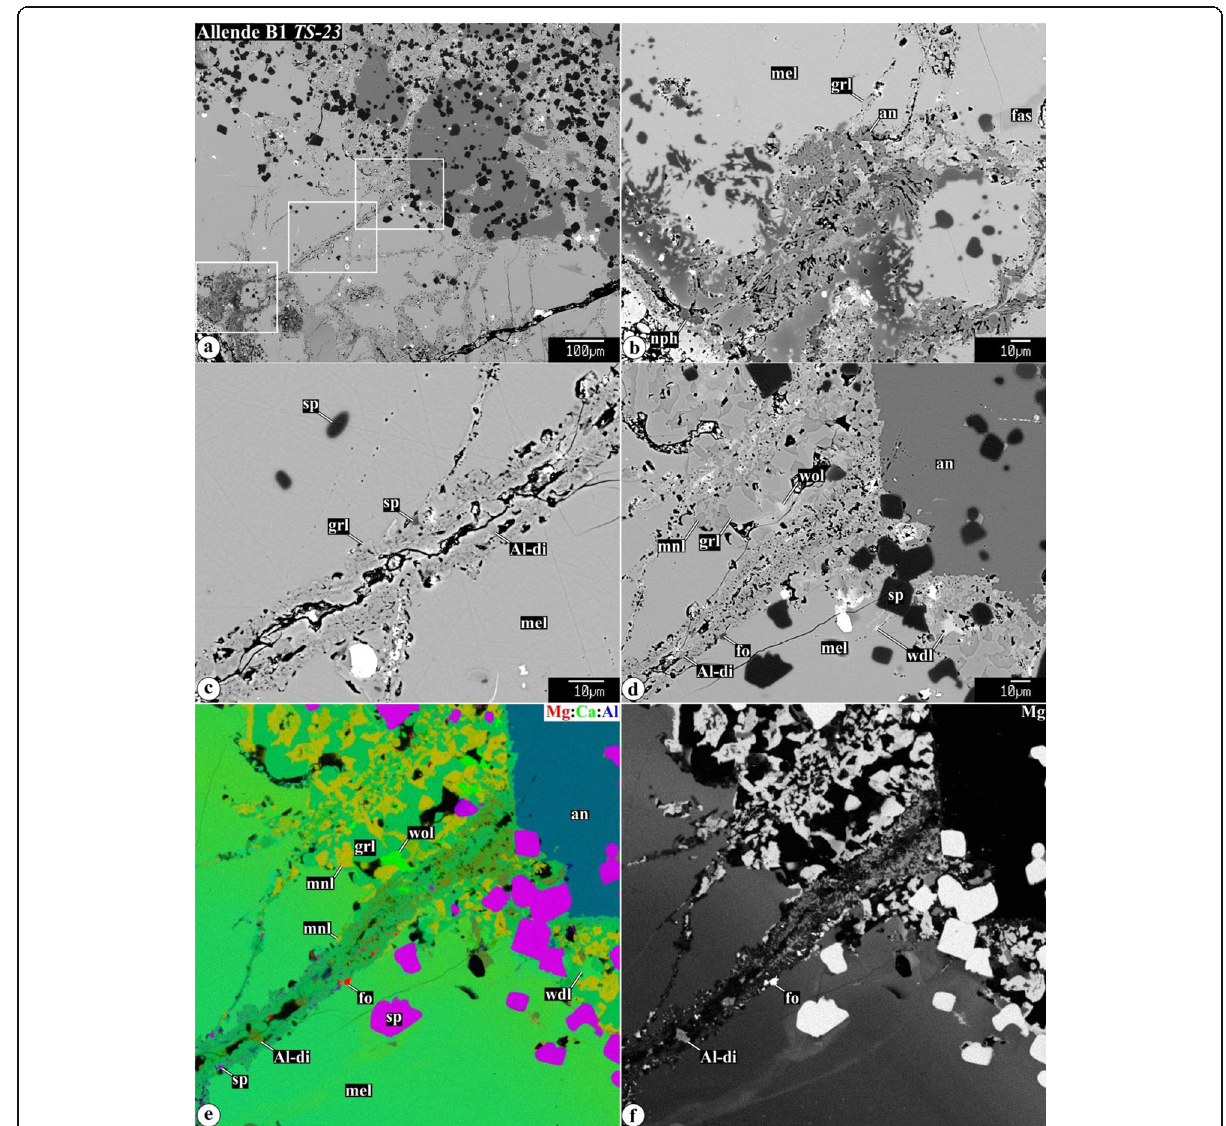
Fig. 5 a − d Backscattered electron images, e combined x-ray elemental map in Mg (red), Ca (green), and Al (blue), and f elemental map in Mg of a vein crosscutting gehlenitic melilite mantle around Type B1 CAI TS-23 . Regions outlined in a are shown in detail in b , c , and d − f , respectively. Towards the CAI interior, the melilite becomes more åkermanitic. The mineralogy of the vein changes towards the CAI interior from anorthite-rich to grossular-rich; minor phases include Al-diopside, forstetrite, and spinel. Åkermanitic melilite in the core is replaced by coarse-grained grossular, monticellite, wollastonite, and minor